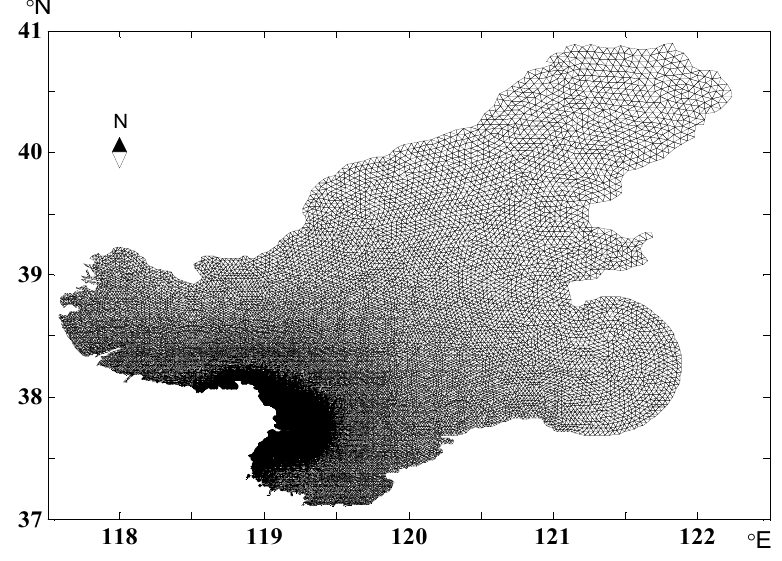
Figure 2. Grid information for the research area.